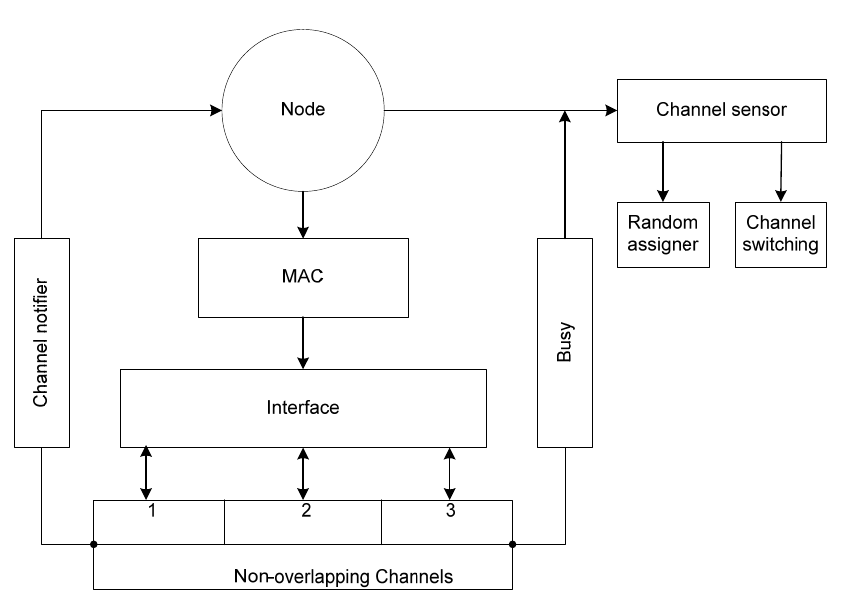
Figure 2. MC-DCF design model.